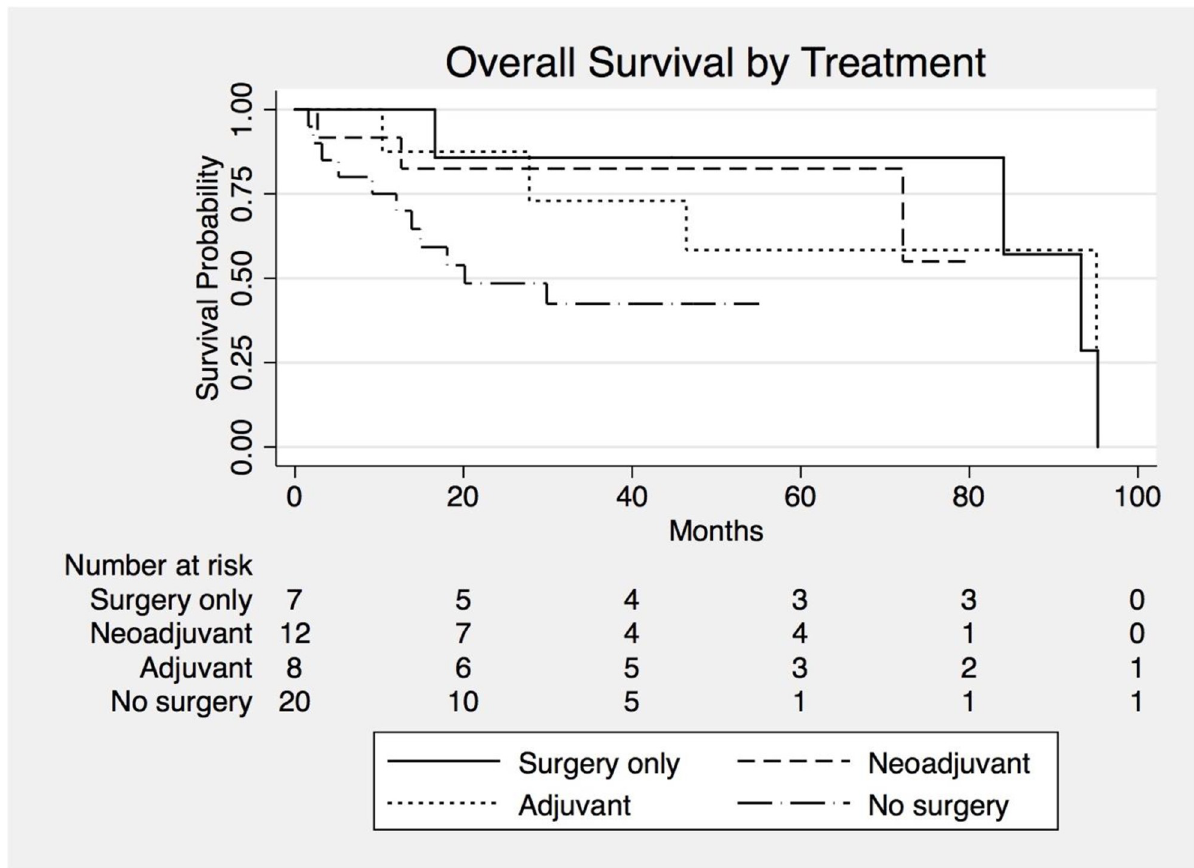
Fig 2. Overall survival by type of therapy. Kaplan-Meier curves for overall survival by surgery and perioperative chemotherapy.